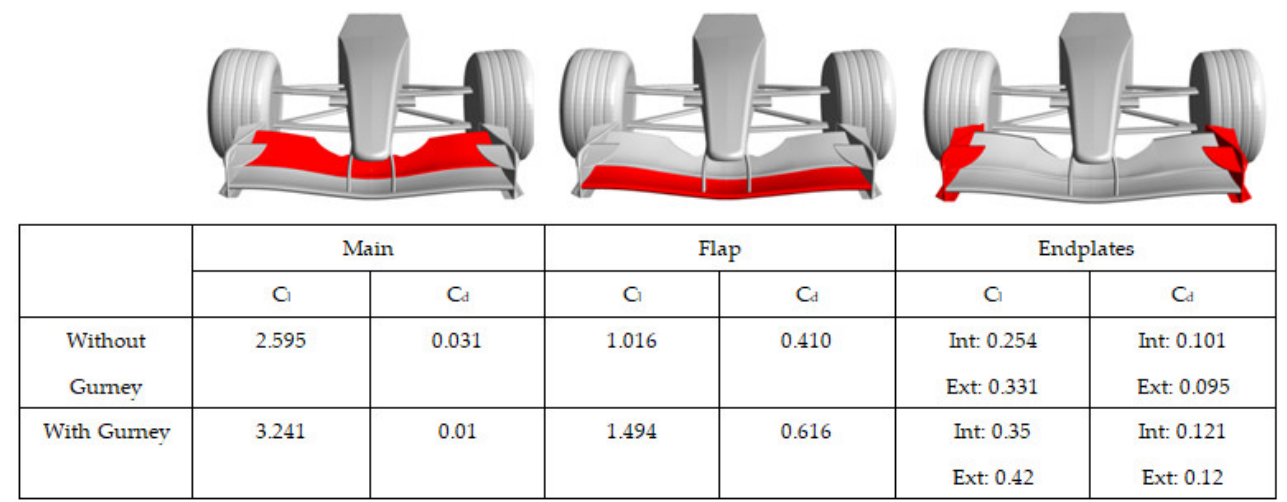
Figure 6. C l and C d performance comparison on main, flap, and endplates. With the GF, a downforce increase of about 30% on the flap and on the endplates and 20% for the main was observed; on the other hand, the drag increased by 33% and 24% on the flap and on the endplates, respectively, but decreased on the main by 67%. The effects on the suspensions (upper and lower), the wheels, and the body of the vehicle are reported in Table 1. Table 1. Percentage variation of aerodynamic forces on suspension, tire and vehicle body. Suspensions Tire Vehicle Body